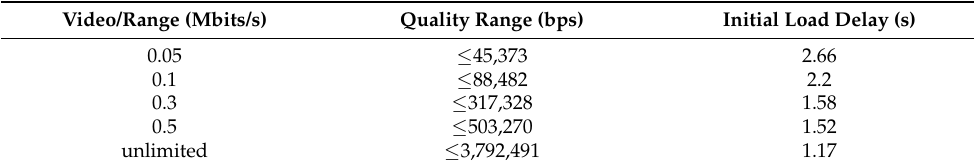
Table 7. Experiment